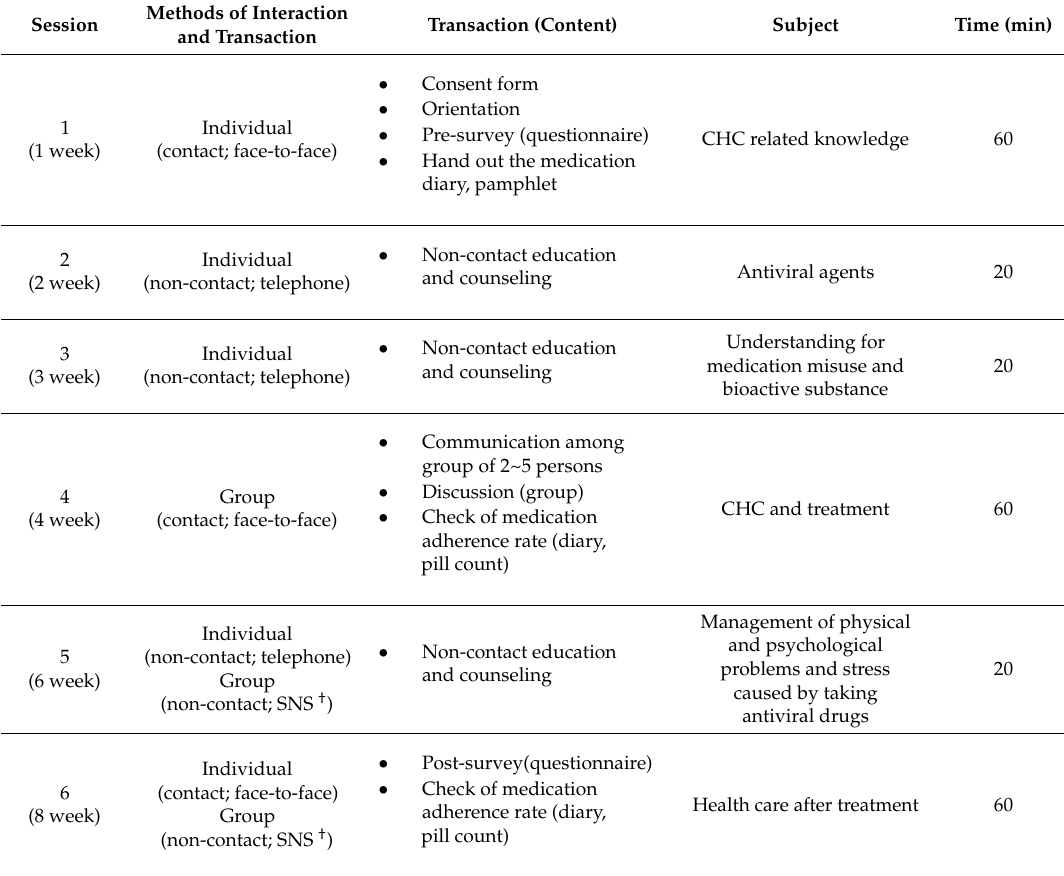
Table 1. Content of the antiviral agent medication adherence education program